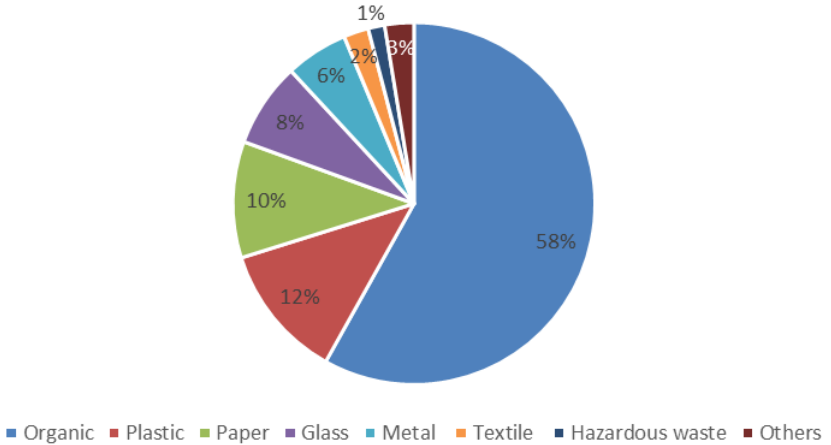
Figure 1. Characteristics of the solid waste (SW) generated by hotels in Gammarth and Hammamet.